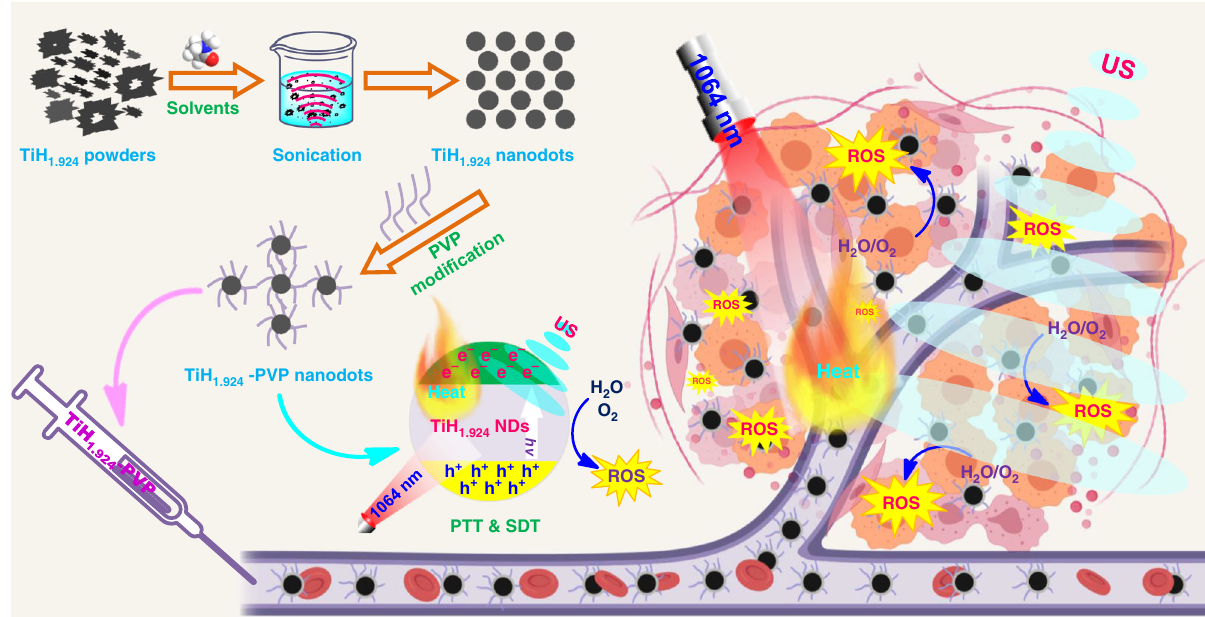
Fig. 1 The preparation and application of TiH 1.924 nanodot. Schematic illustration to show the preparation of TiH 1.924 nanodots by liquid-phase exfoliation and their applications for combined photothermal-sonodynamic cancer